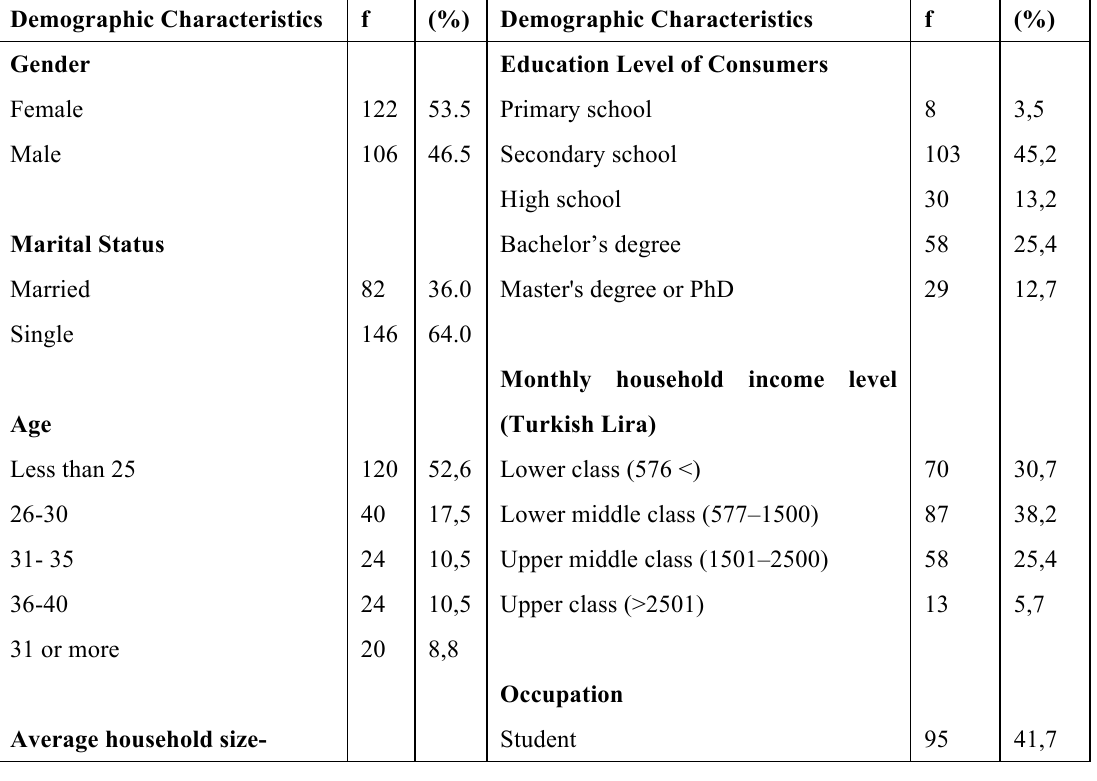
Table 1: Descriptive Statistics of Turkish consumers Demographic